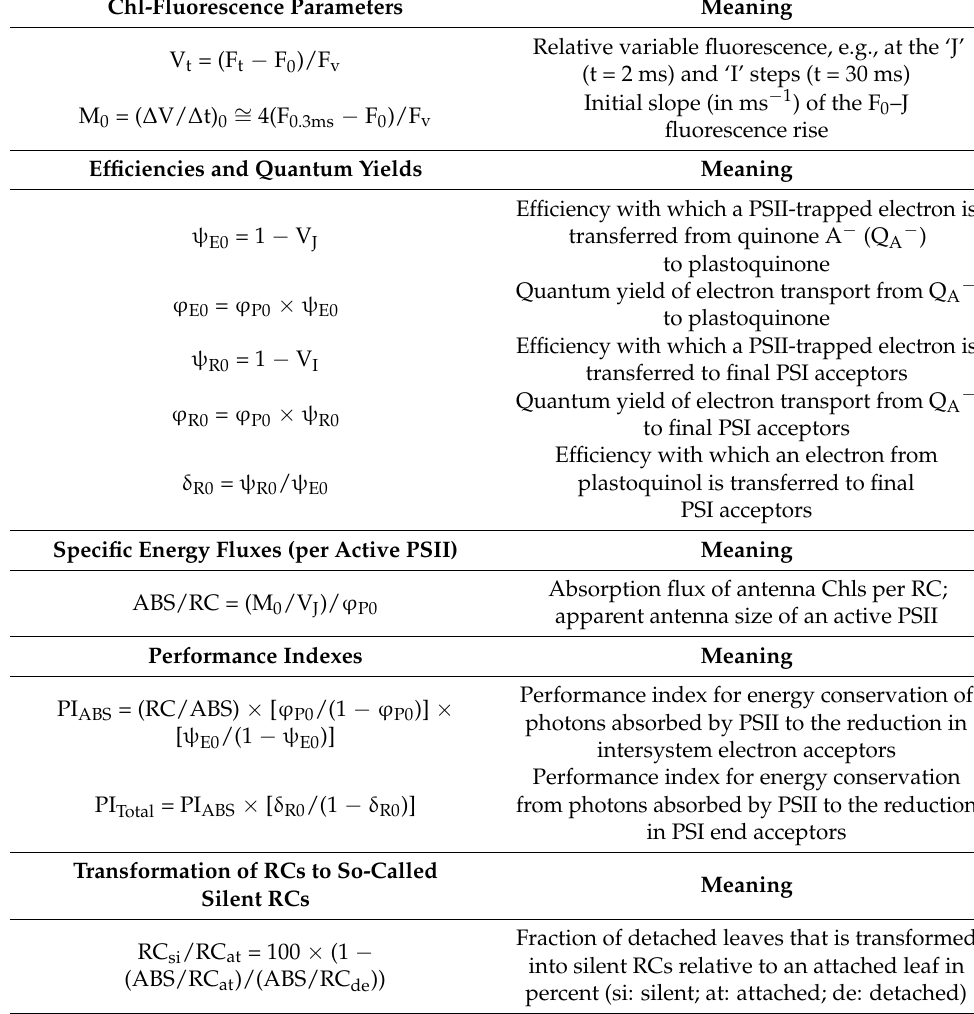
Table 2. Definition of energy fluxes and fluorescence parameters of the ‘JIP’ Chl-transient fluorometry after Strasser et al. and Stirbet et al. [29,31] as far as not mentioned in Table 1. Chl-Fluorescence Parameters Meaning Relative variable fluorescence, e.g., at the V t = (F t − F 0 )/F v